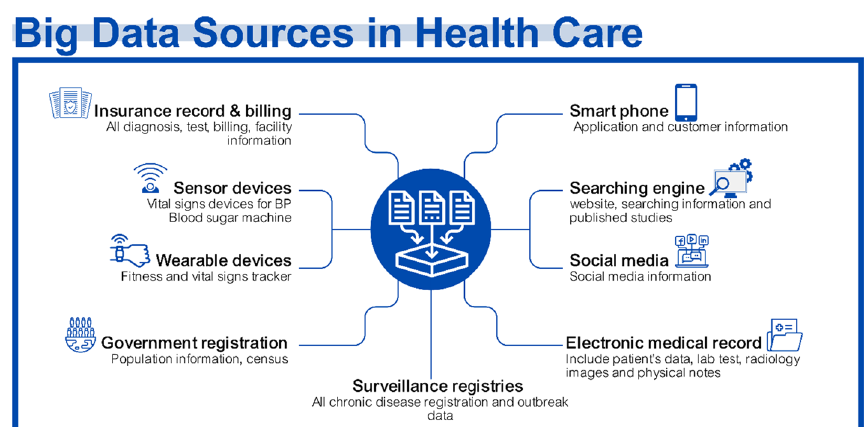
Fig. 1 Big data sources in health care (Source: